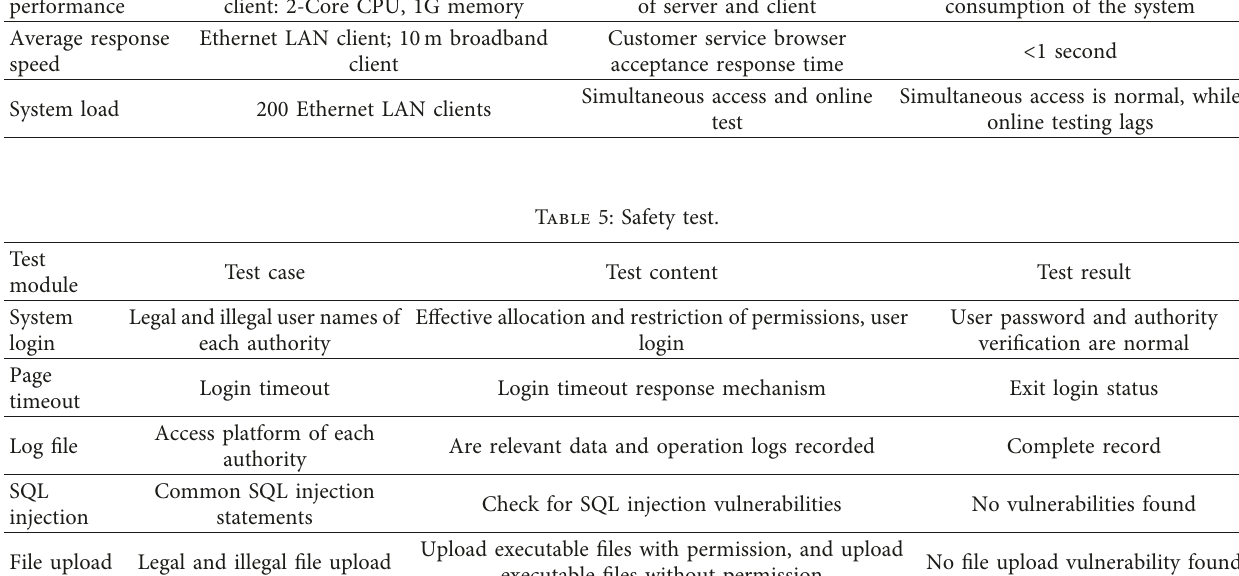
Table 4: Performance test.